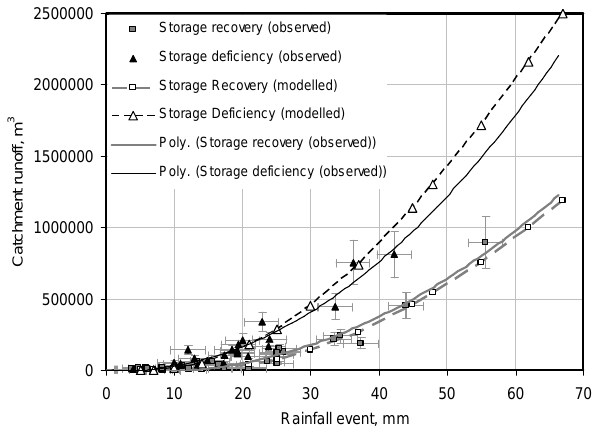
Figure 6. Catchment volumetric runoff (modelled and observed) during storage recovery and storage deficiency stages; the error bars show the standard deviation between the long-term daily rainfall records at the two local weather stations equal to 5 mm and the error related to the flow measurements estimated as ±20%.